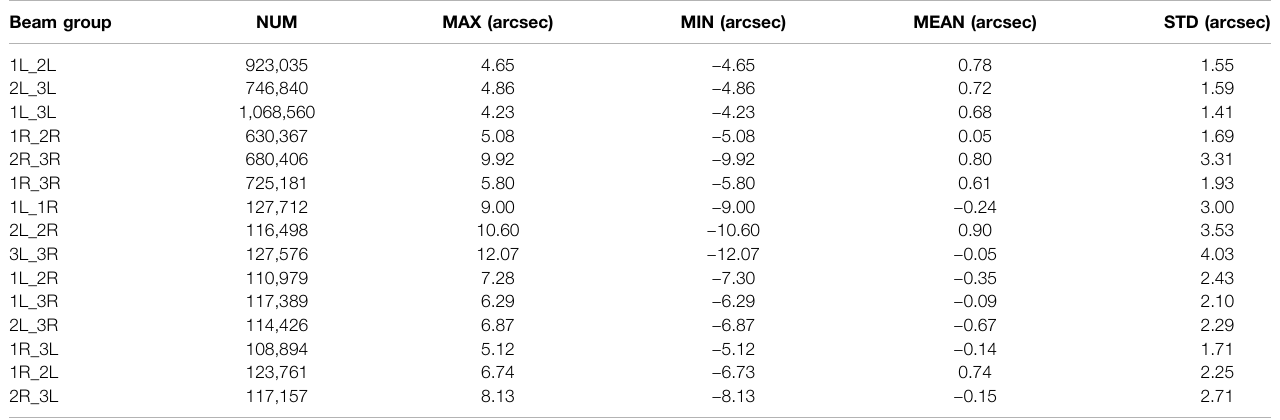
TABLE 5 | Statistical information of IS-2 CTVD.